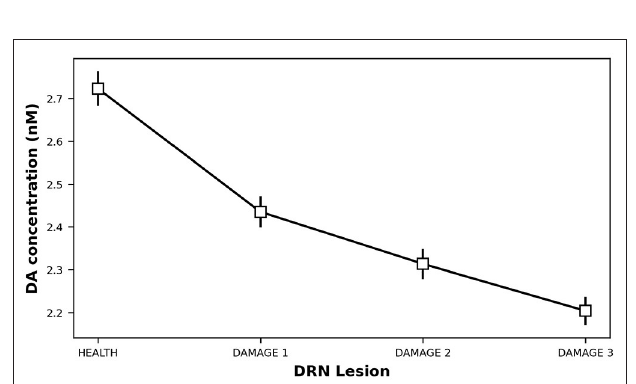
FIGURE 4 | Dopamine concentration vs. 5-HT release impairments. DAMAGE1 = τ DRN + 40 % ; DAMAGE2 = τ DRN + 60 % ; DAMAGE3 = τ DRN + 80 % .